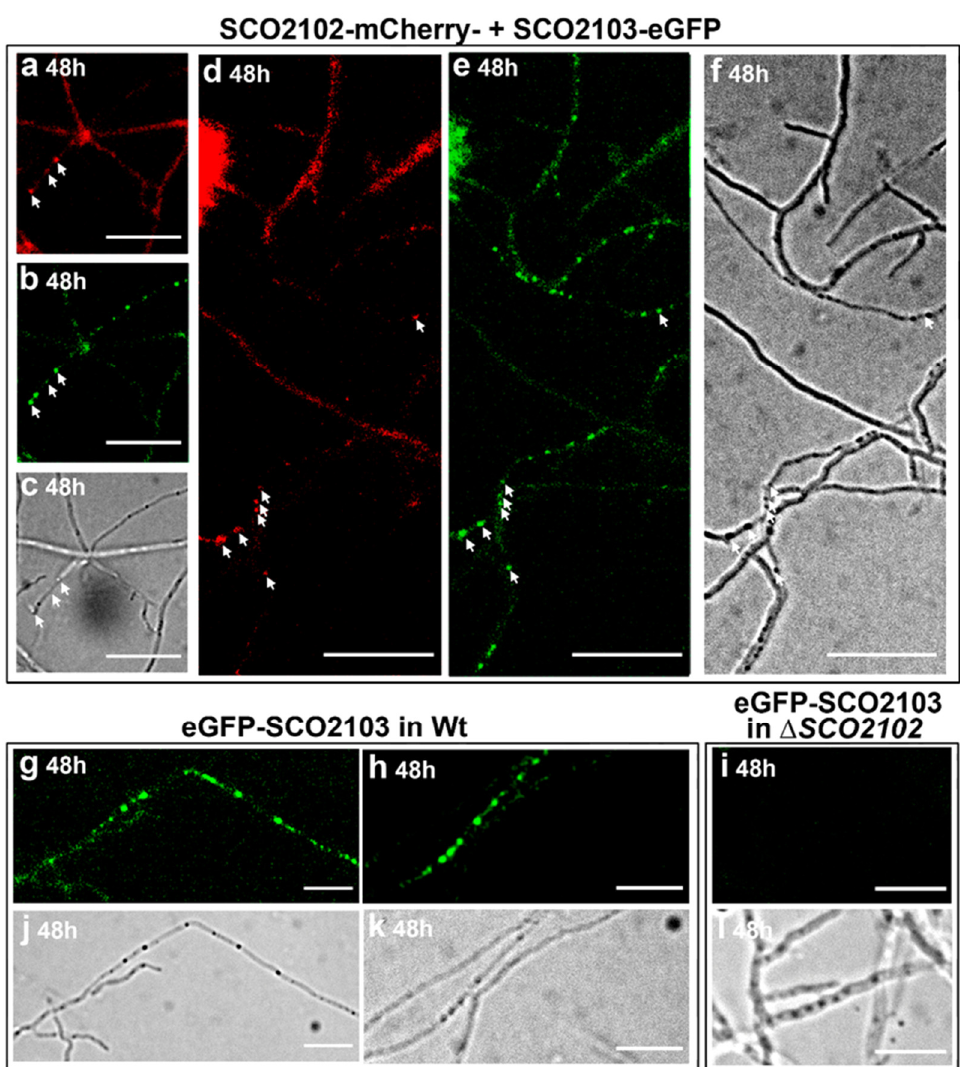
Figure 8. SCO2102-mCherry and SCO2103-eGFP dynamics in sporulating SFM solid cultures. ( a – f ) SCO2103-eGFP (green) and SCO2102-mCherry (red) cellular localisation in the S. coelicolor wild- type strain. All SCO2102-mCherry spots co-localise with SCO2103-eGFP spots (arrows), but there are SCO2103-eGFP spots that do not co-localise with SCO2102-mCherry spots. ( g – l ) SCO2103-eGFP expressed in the wild-type and the ∆ SCO2102 knockout strains. Fluorescence and phase-contrast microscope images are shown. Scale bars 5 µ